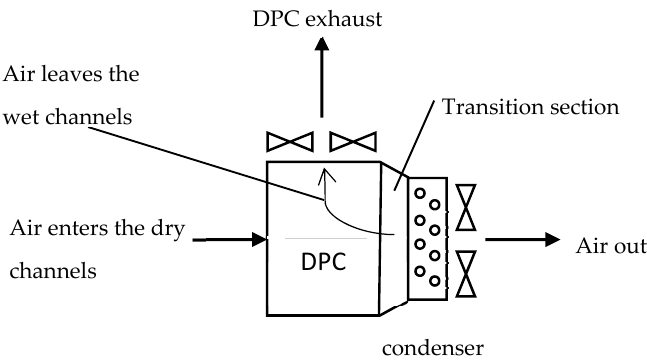
Figure 2. Sketch of the dew point cooler (DPC) and condenser.